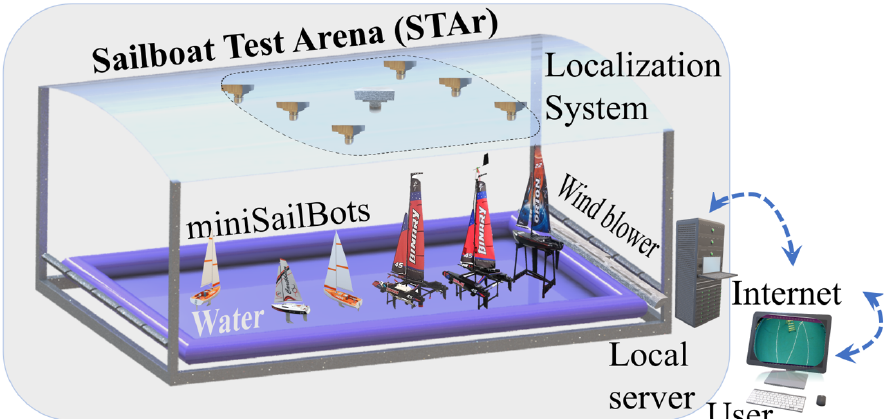
Figure 1. STAr architecture. The platform comprises of miniature sailing robots (miniSailBots), an arena including an 6 m (length) × 6 m (width) pool with 0.3 m depth water, a quasi controllable wind field, a localization system and a network